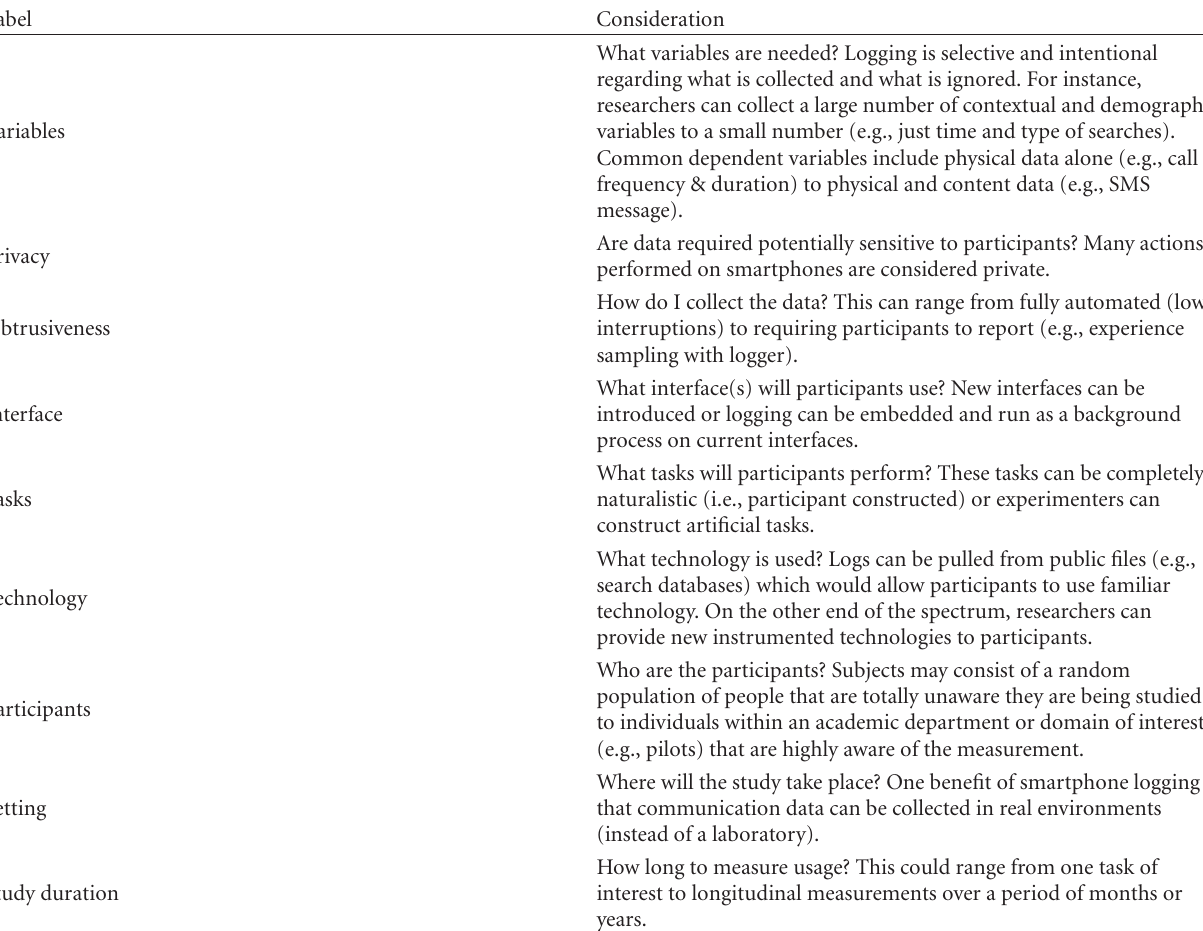
Table 1: Nine constraints for designing a study using logger